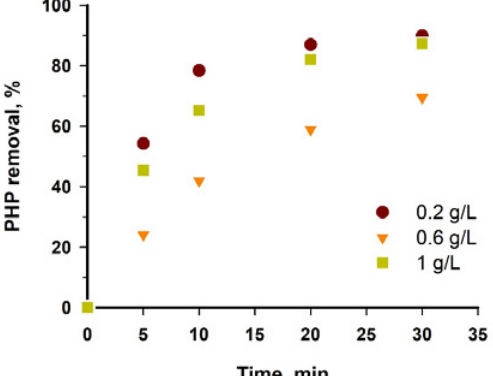
Fig. 8. PHP removal efficiency of the HSEF at different ultrasonic power. Reaction conditions: pH=7, 0.1Fe-ZSM-5 concentration of 0.2 gL -1 , applied current of 100